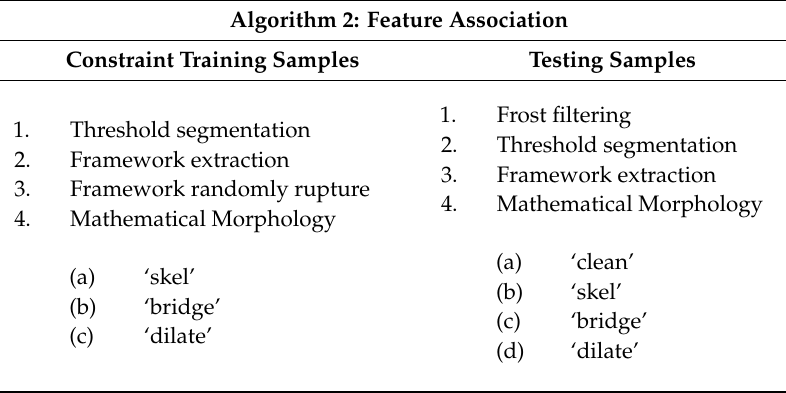
Table 2. FA for constraint training and testing samples. Algorithm 2: Feature